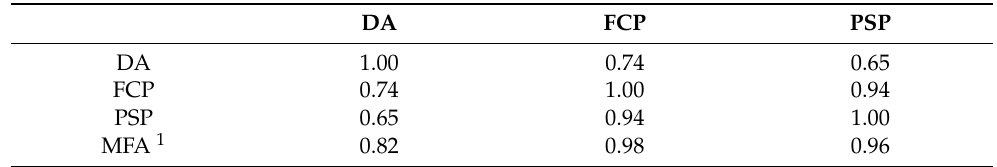
Table 4. RV coefficients of descriptive analysis (DA), free-choice profiling (FCP), and polarized sensory positioning (PSP)